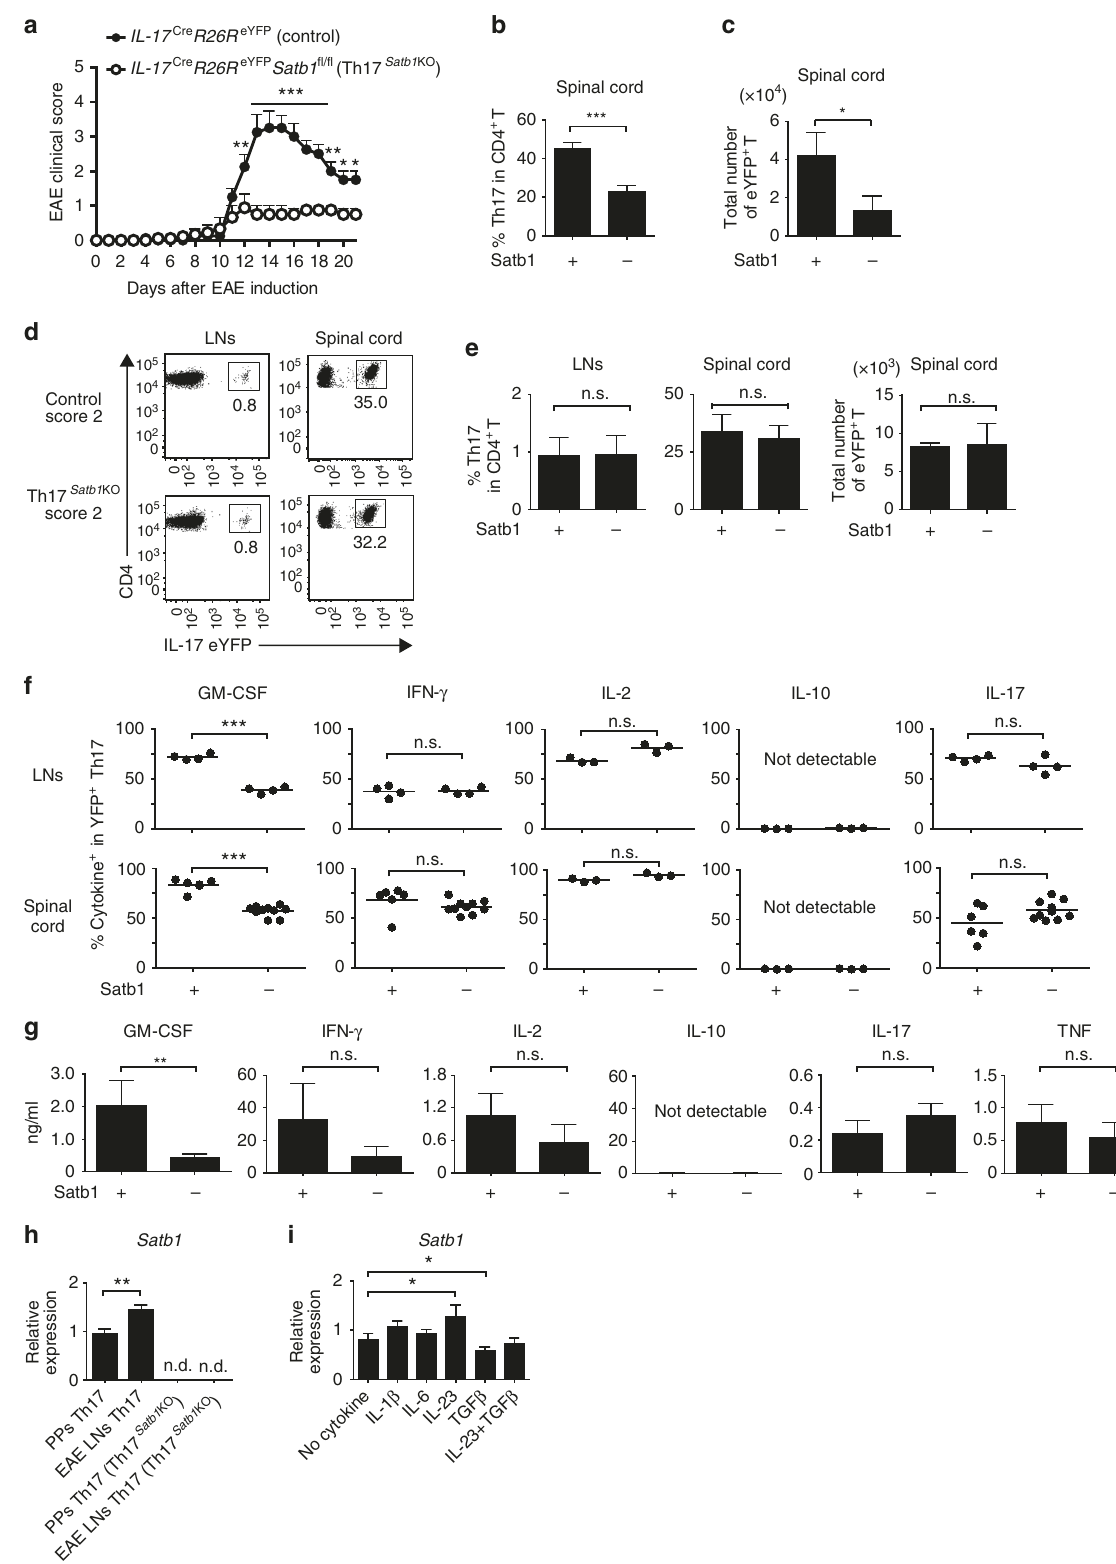
(Fig. 2h). In vitro re-stimulation of draining LN Th17 cells from control EAE mice with IL-23, but not IL-1 β and IL-6 increased Satb1 expression, whereas TGF- β restrained its effect, consistent with the previous report 42 (Fig.